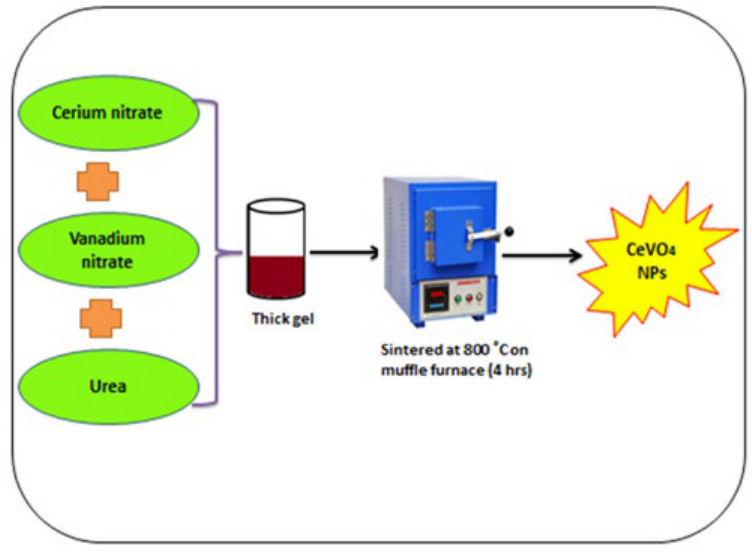
Fig. 1. Schematic diagram for the synthesis of CeVO